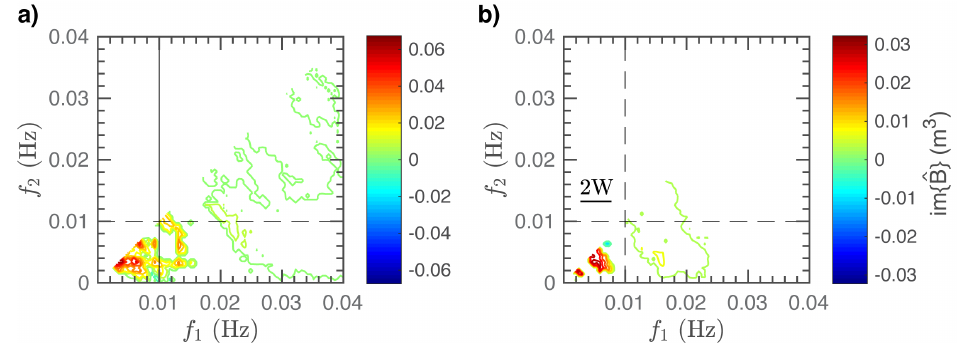
Figure 8. The imaginary component of the bispectrum im { ˆ B ( f 1 , f 2 ) } generated using four 17 min records (zero-padded) of the high-passed pressure head as measured in the backshore at Matagorda Peninsula (PT-1) for two time periods during overwash that were deemed sufficiently stationary: ( a ) − 4 to − 3 h and ( b ) − 3 to − 2 h. A time bandwidth of 5 and 9 Slepian tapers were used, resulting in a passband bandwidth 2 W of 0.005 Hz and about 64 dof per frequency. The dashed lines partition the IG frequency band into low- and high-frequency components. Bispectral estimates are set to zero below a bicoherence of